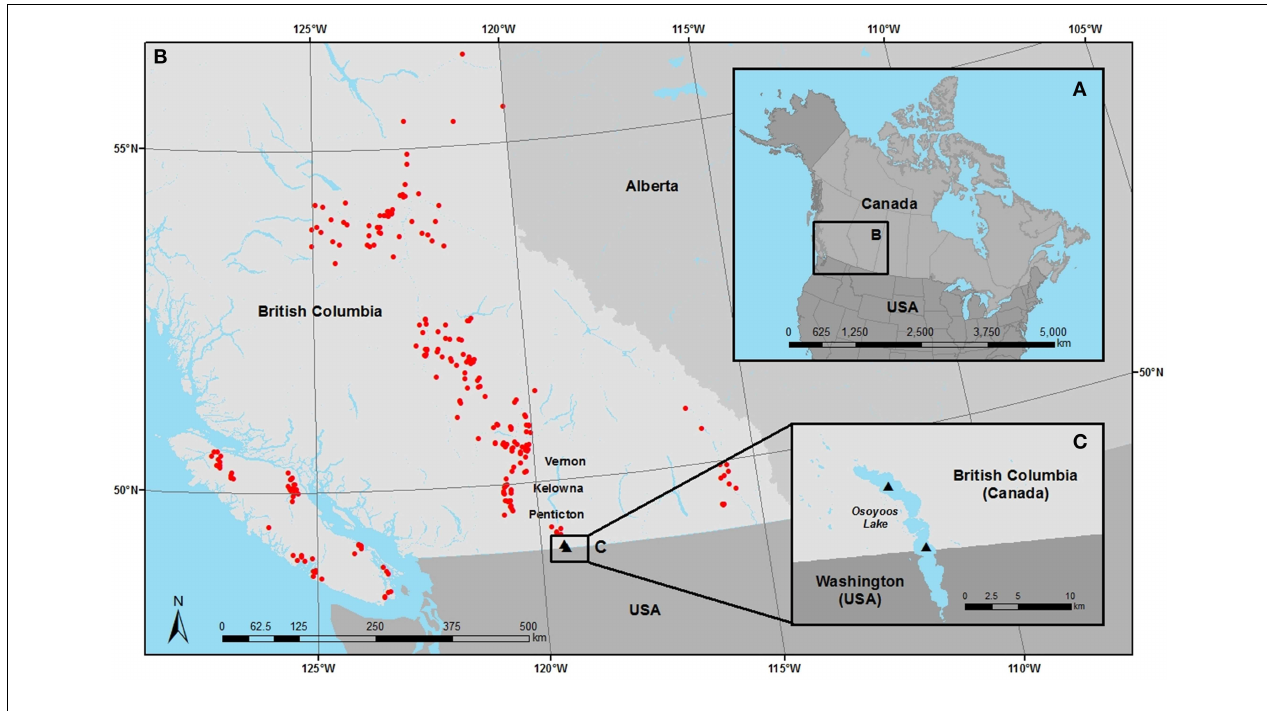
were taken to characterize the modern-day diatom assemblages, and (C) the location from where sediment cores were removed from the north and south basins of Osoyoos